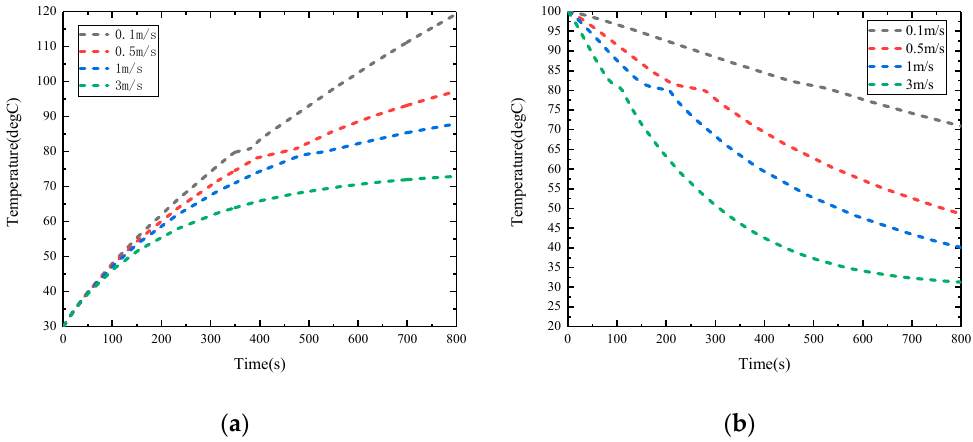
Figure 6. The time-temperature curves for four air velocities. ( a ) The time-temperature curves under full load conditions; ( b ) The time-temperature curves under no-load conditions.